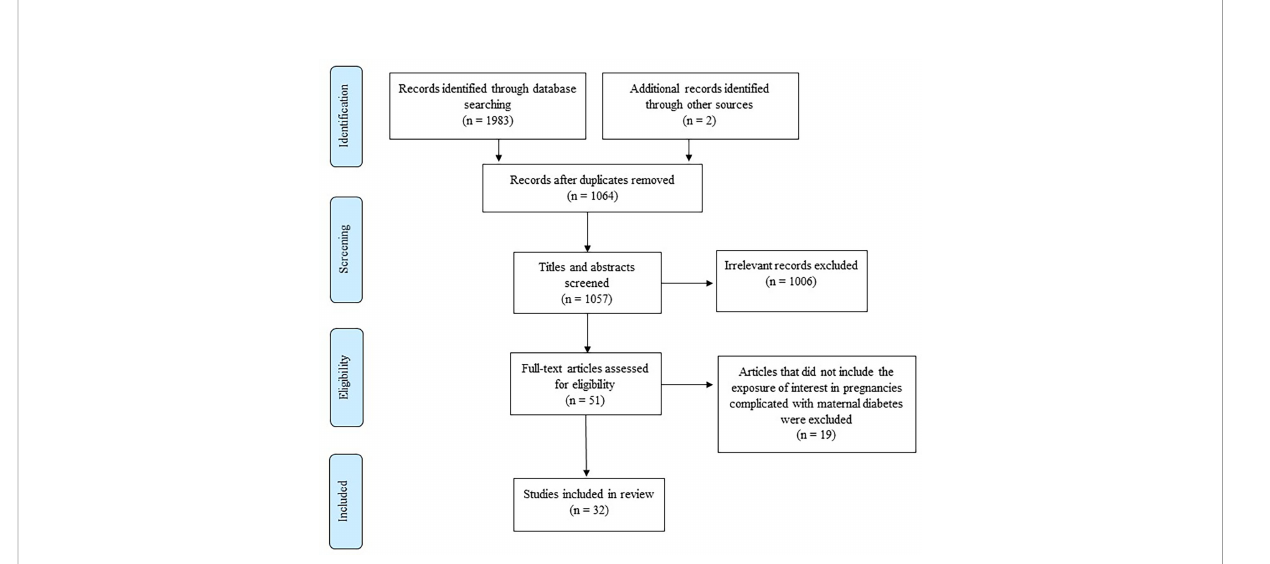
FIGURE 1 Flow diagram showing the selection of studies for inclusion in the review [adapted from